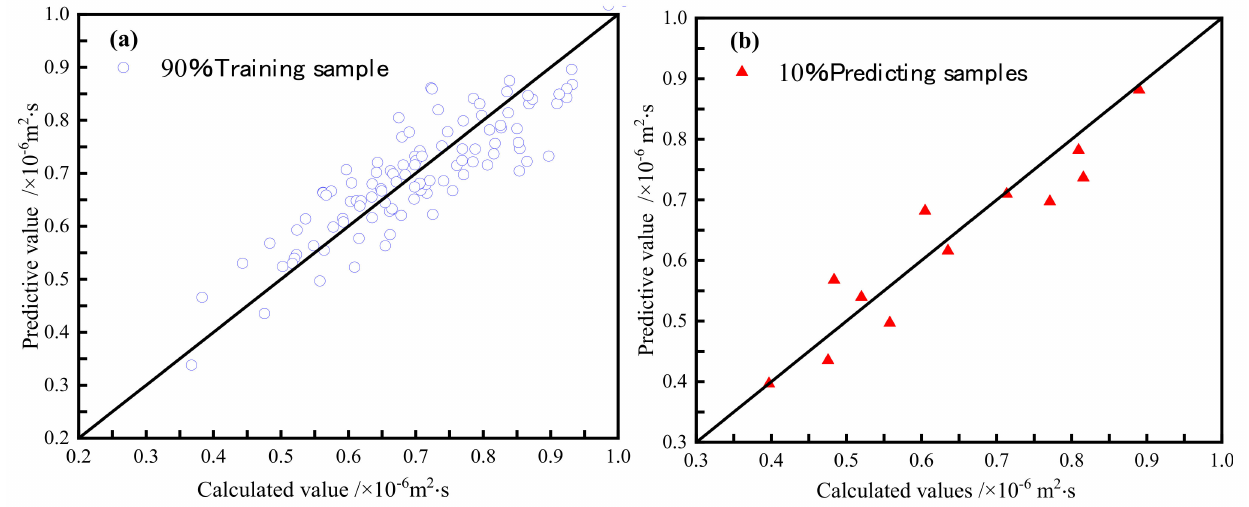
Figure 12. RBF neural network prediction results of thermal diffusivity of unfrozen soil: ( a ) training samples and ( b ) prediction samples.